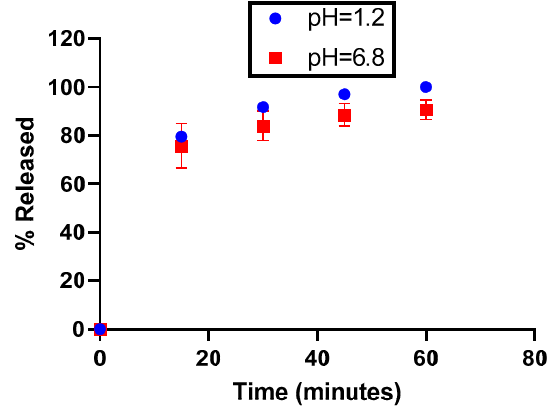
Figure 3. Release profiles of EGCG as a function of the pH.